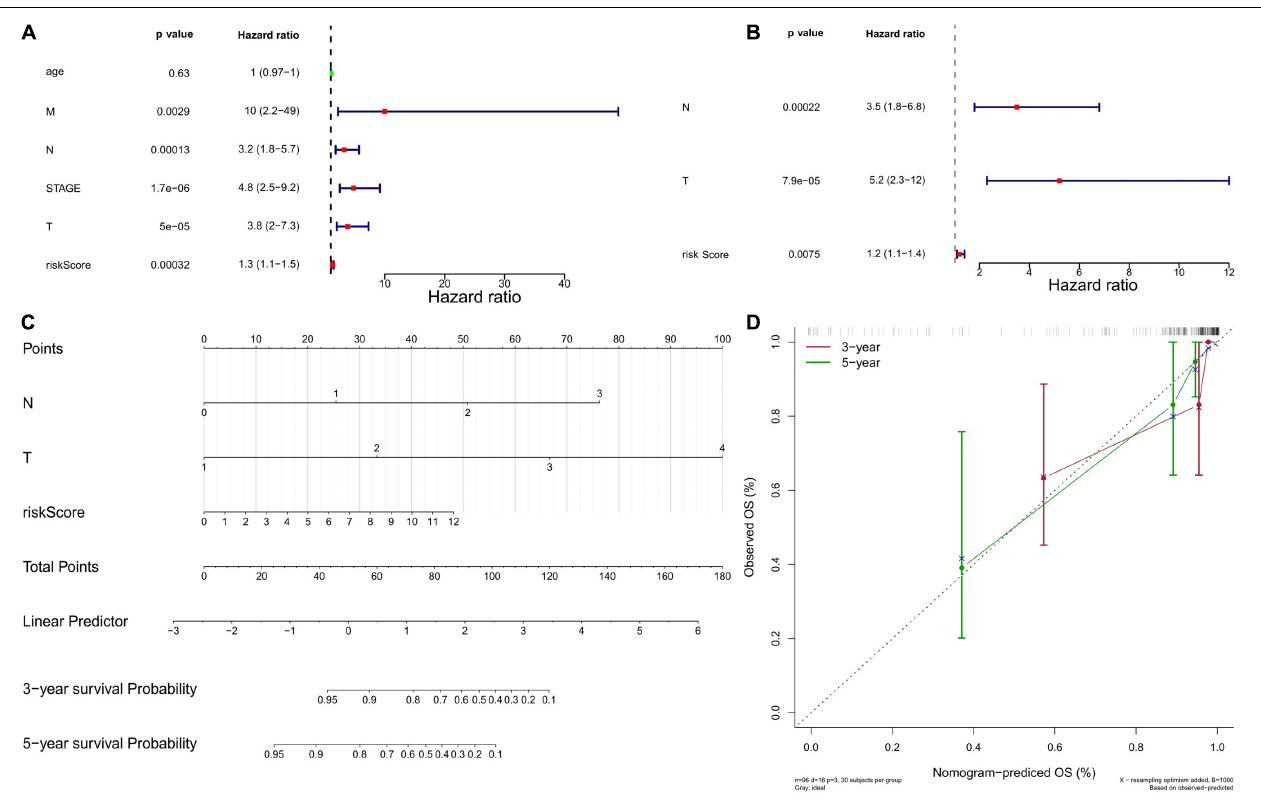
FIGURE 5 | Independent prognostic value of the six-gene prognostic model. (A) Independent prognostic factors as determined by the Univariate Cox regression analysis. The left side represents the gene, corresponding P value, and HR value. The red square on the right indicates that the HR value is greater than 1, the green square indicates that the HR value is less than 1, and the line segments on both sides of the square are 95% confidence intervals of the HR value. (B) Independent prognostic factors as determined by the Multiple Cox regression analysis. (C) The nomogram to predict overall survival was created based on three independent prognostic factors. Each factor corresponds to a score, and the sum of the total scores of each factor corresponds to the total score. The 1-year, 3-year, and 5-year survival rate is predicted according to the total score. (D) The correction curve based on the above prediction model. The c-index of the model is 0.902371, and the corrected c-index is